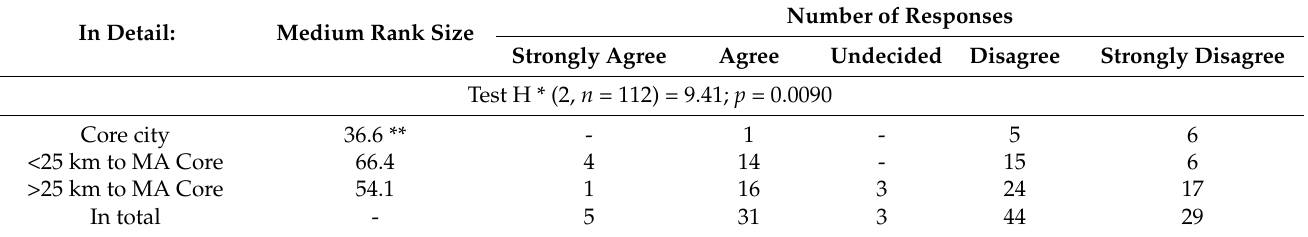
Table 12. Experts’ opinions on the occurrence of processes of specialization in vegetable and/or fruit production until 2027 ( n = 112). In